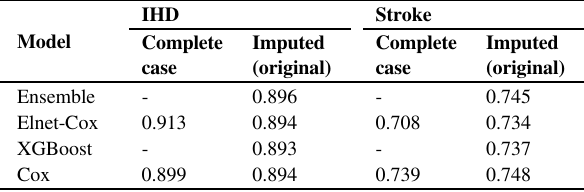
Table 1 Discrimination metrics (Harrell ’ s C) for IHD and stroke